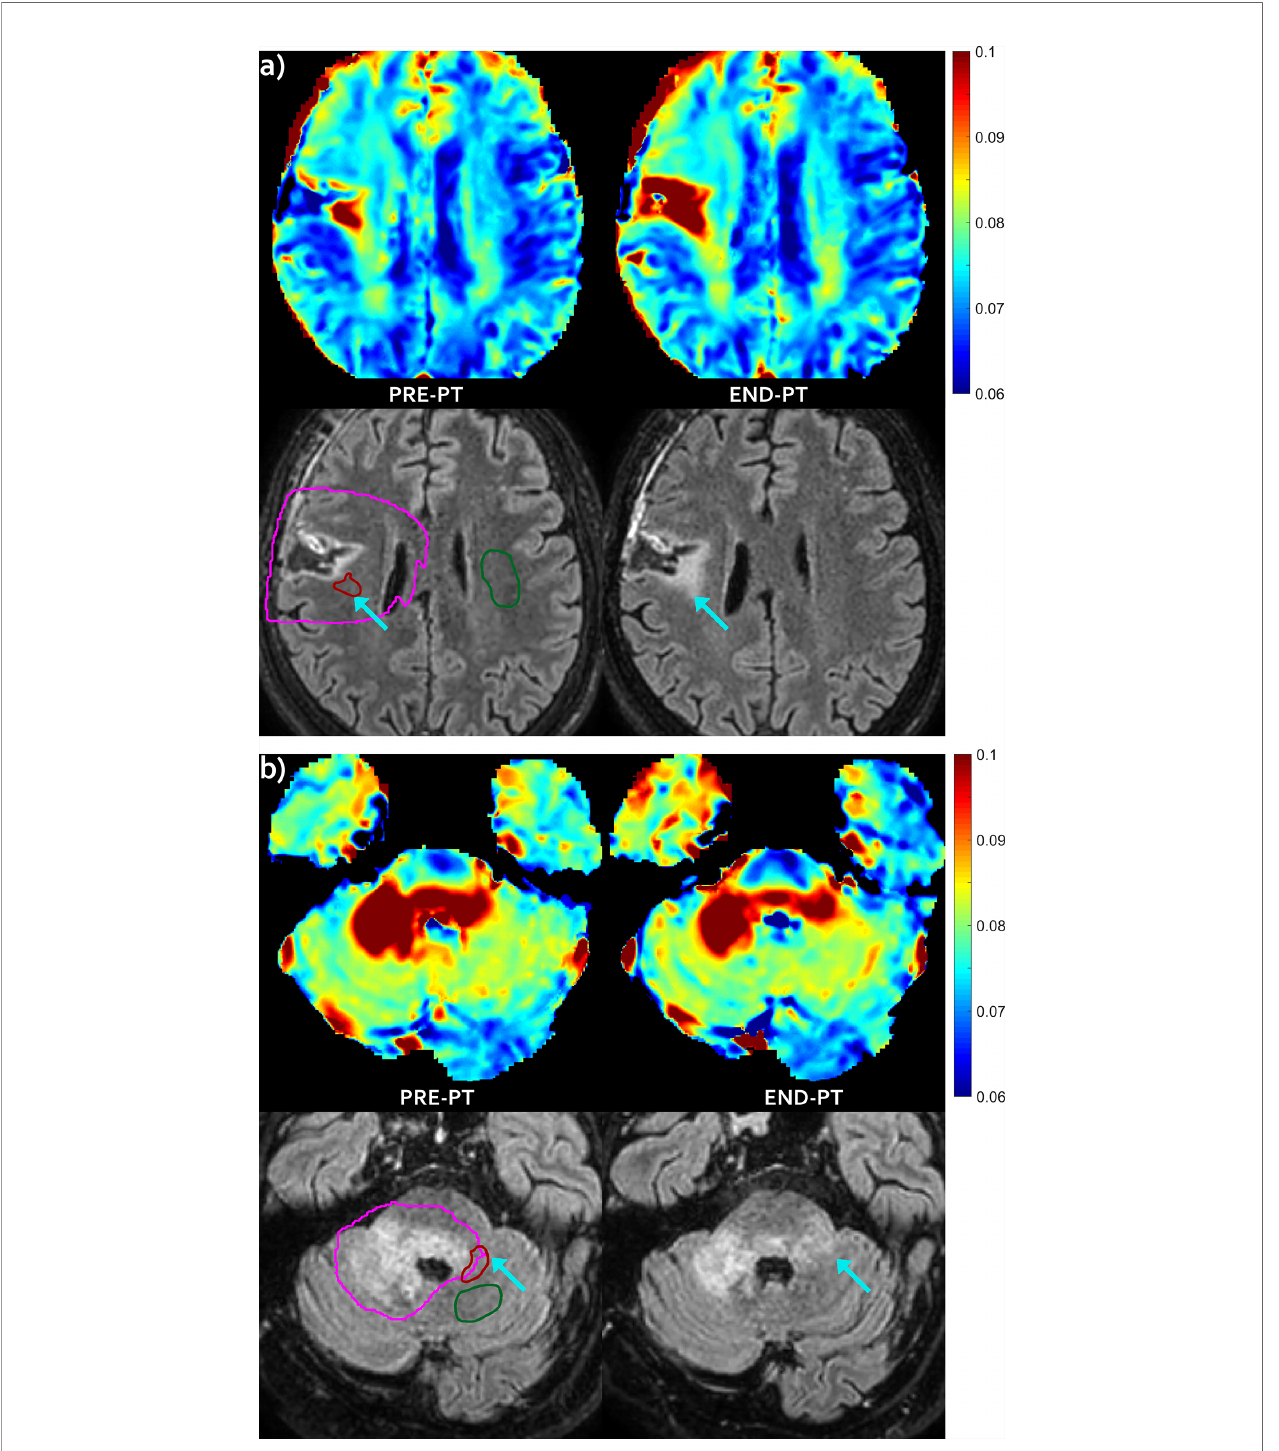
FIGURE 2 | FLAIR increase pattern — Evolution pattern observed in patient #3 (A) and in patient #6 (B) as highlighted by the arrows. The mismatch, i.e. the abnormal T2 area that extended outside hyper-intense FLAIR area before proton irradiation (left) evolved into a new area of FLAIR hyper-intensity at end-PT (right), that was diagnosed as radiation induced damage. T2 intra/extracellular water maps (top) and FLAIR images (bottom) are shown. Colored bar is shown in seconds. On pre-PT FLAIR image the contours of the CTV (violet line), of the mismatch ROI (red line) and of the contralateral healthy ROI (green line) are shown.